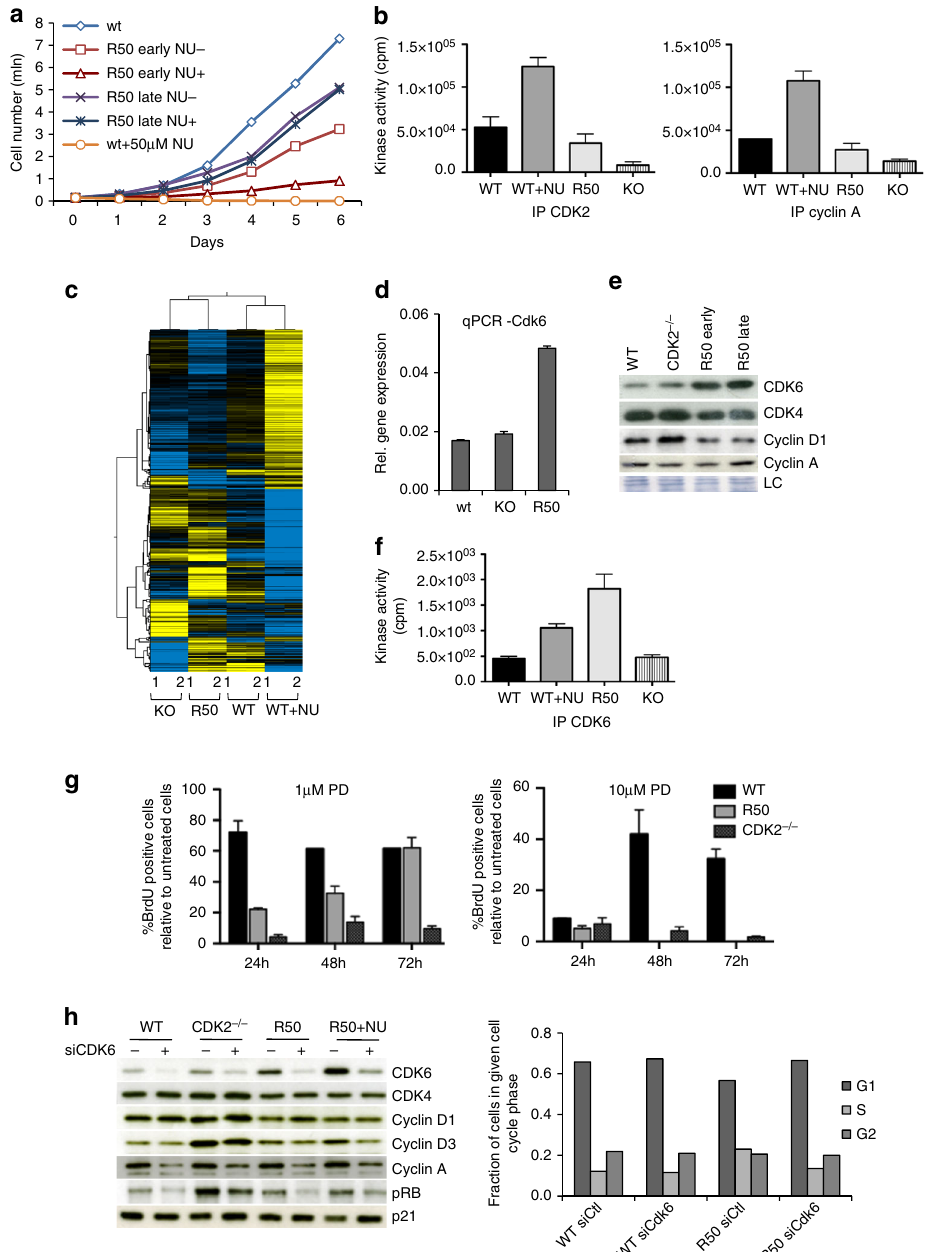
Fig. 2 Cell cycle rewiring in CDKi-resistant cells. a HCT116 WT and R50 early and late cells were grown in the absence or presence of 50 μ M NU6102 and the cell number was evaluated every day for 6 days. Representative of three independent experiments. b Kinase activity assayed in vitro on CDK2 and cyclin A immunoprecipitates from WT, WT cells treated for 24h with 20 µ M NU6102, R50 and CDK2 − / − (KO) cells (mean ± SD of 2 independent experiments performed in triplicates). c Heat-map of 2300 genes differentially expressed between WT, CDK2 − / − (KO), R50, and WT cells treated with 20 µ M NU6102 for 24h; analysis was performed in duplicates. Upregulated genes are indicated in yellow, downregulated in blue. d qRT – PCR analysis of CDK6 expression in WT, CDK2 − / − (KO) and R50 cells (mean ± SD of three replicates). e Western blot analysis of the proteins indicated in WT, CDK2 − / − and R50 early and late cells. f Kinase activity assayed in vitro on CDK6 immunoprecipitates from WT, WT cells treated for 24h with 20 µ M NU6102, R50 and CDK2 − / − (KO) cells (mean ± SD of two independent experiments performed in triplicates). g WT, R50 and CDK2 -/- cells were grown in the absence or presence of palbociclib (1 μ M or 10 μ M; PD0332991, PD) for 24h, 48h and 72h, pulsed for 15min with BrdU, and analysed for BrdU incorporation relative to untreated cells (mean ± SD of a representative experiment performed in triplicates). h CDK6 was downregulated with siRNA in WT, CDK2 − / − , R50 and WT cells treated with 20 µ M NU6102 for 24h. After 24h, the expression of indicated proteins (left) and cell cycle distribution (right) were